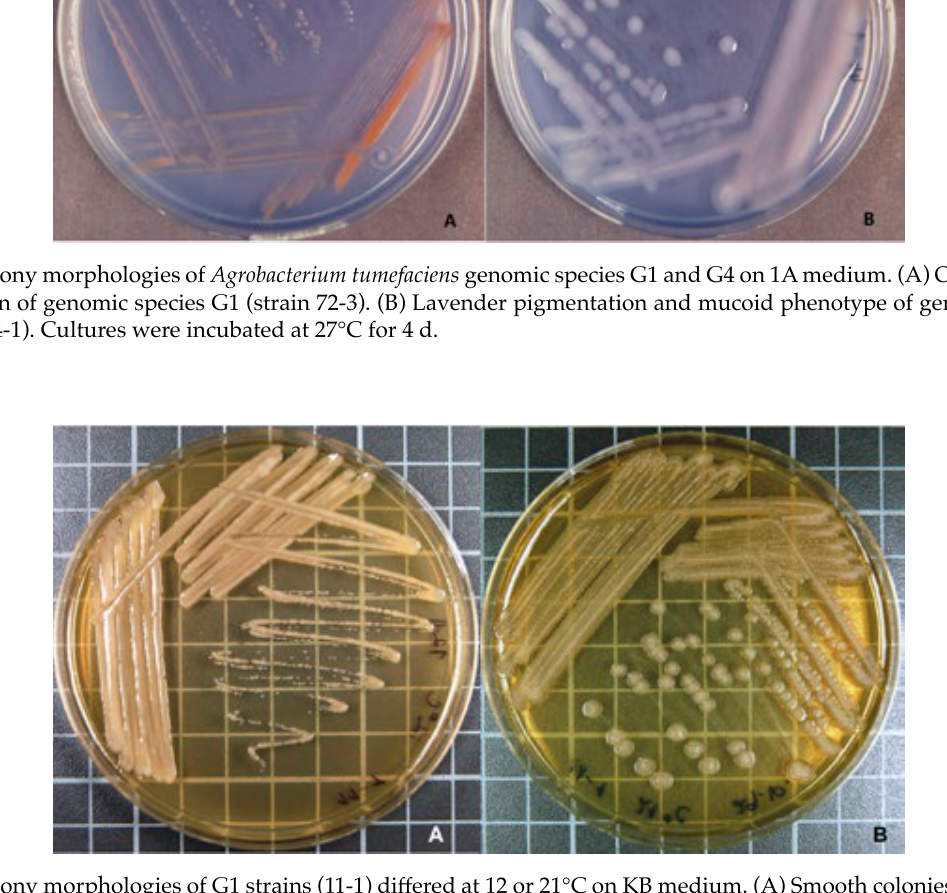
Figure 2. Colony morphologies of G1 strains (11-1) differed at 12 or 21°C on KB medium. (A) Smooth colonies at 12°C after 1 week. (B) Rough colonies at 21°C after 4 d.